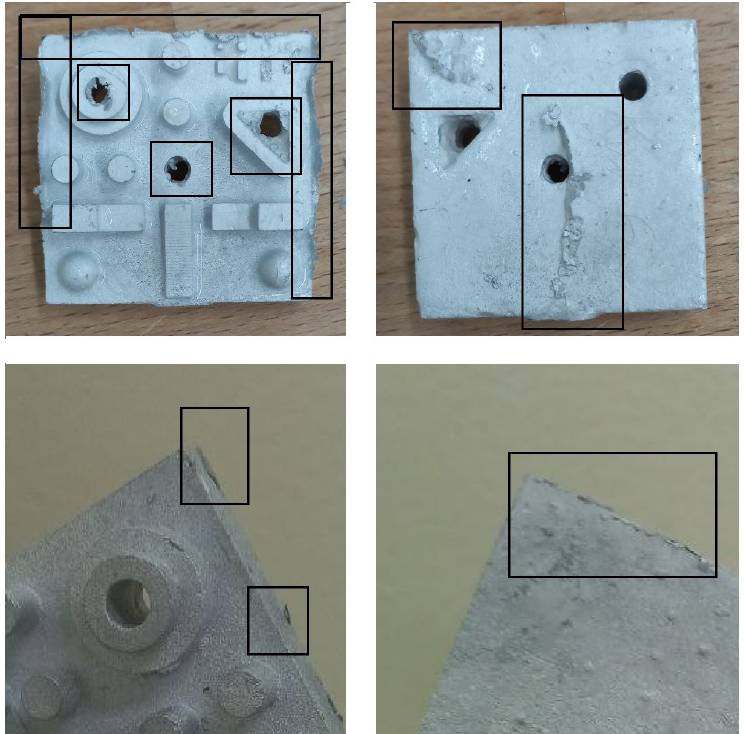
Figure A2. Metal penetration issue in cast parts: thin metal flakes on the edges. Table A1. Mean ranking of parameters for dimensional accuracy of patterns.